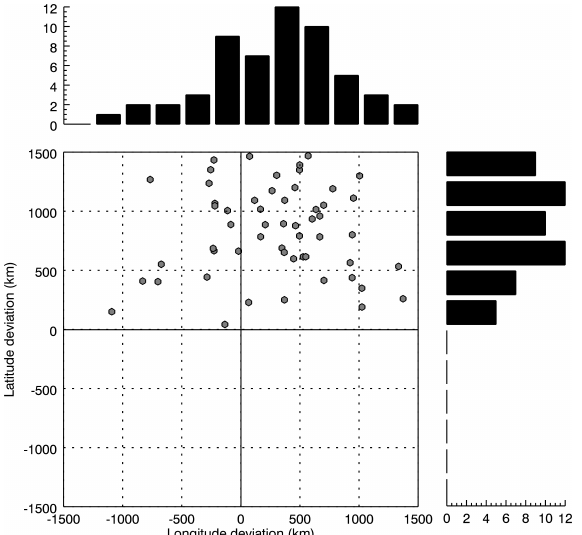
Figure 5. Spatial distribution of the latitudinal and longitudinal lightning–satellite distance with latitudinal and longitudinal his- tograms.